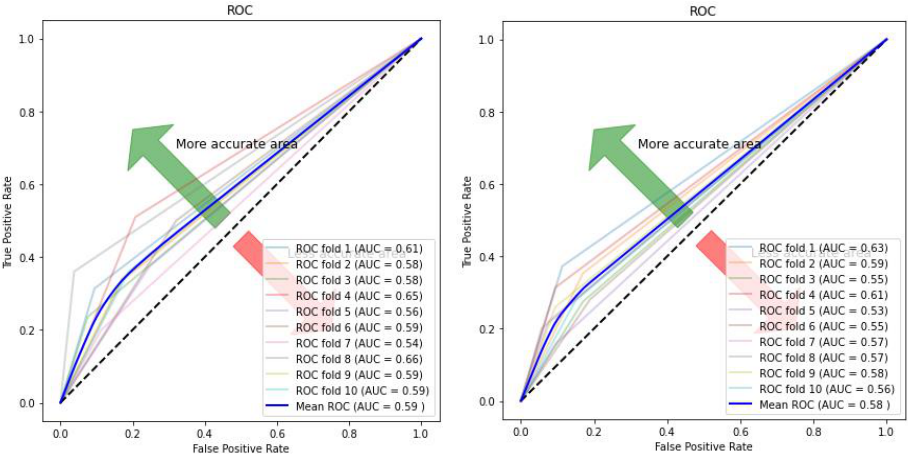
Figure 17. ROC curve and AUC values for autoencoder–KNN ( Left ) and KNN ( Right ). Table 3. Average and standard deviation in accuracy, sensitivity, specificity, and AUC.